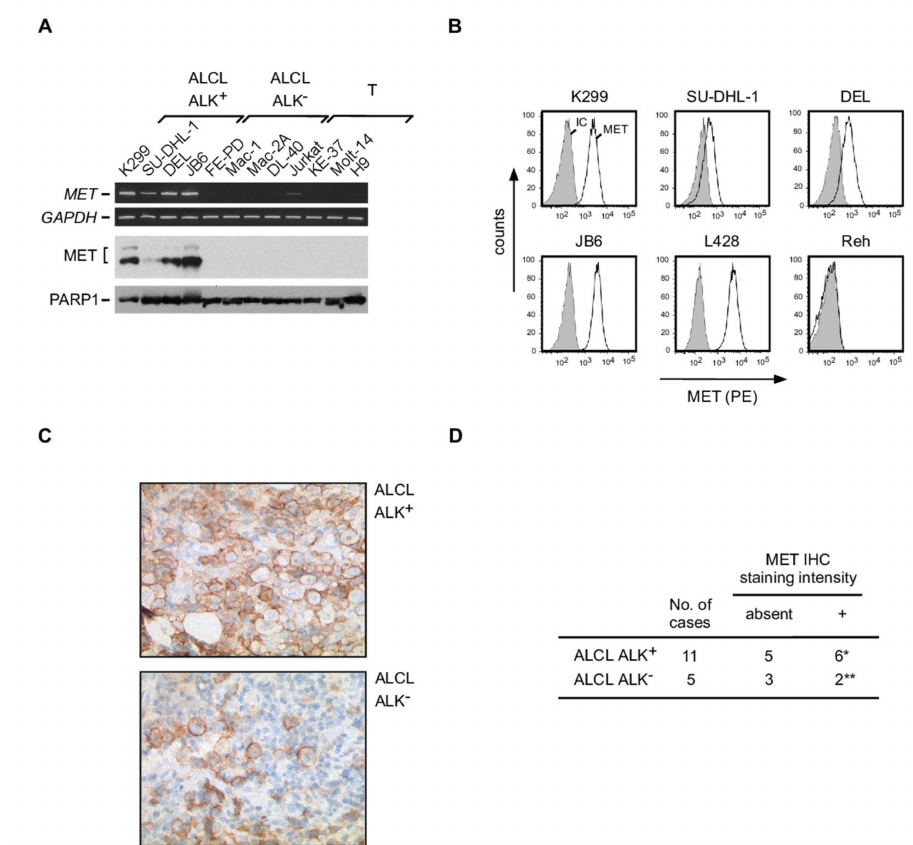
Figure 4. Expression of MET in ALCL. ( A ) Analysis of MET mRNA (upper panel) and protein (lower panel) expression in various ALK + and ALK – ALCL as well as T cell control cell lines, as indicated. The expression levels of GAPDH and of PARP-1 were analyzed as controls, respectively. Note that two MET bands are detectable at the protein level, corresponding to the precursor protein pro-MET (upper band) as well as MET (lower band). ( B ) Cell surface expression analysis of MET in four ALK + ALCL cell lines (K299, SU-DHL-1, DEL, JB6) by extracellular flow cytometry. L428 cells with a known MET expression [48] were included as positive control, Reh cells as negative control. Open histogram, MET staining; filled histogram, isotype control (IC). ( C ) Examples of MET IHC of an ALK + ALCL case (upper panel) and an ALK – ALCL case (lower panel) with moderate tumor cell positivity. Note the cytoplasmic and partially membranous staining of the large ALCL cells. Magnification, 40X. ( D ) Results of MET IHC analyses in ALK + and ALK − ALCL. *, the percentage of positive ALCL cells among the cases was as follows: in 2 cases 60% of the lymphoma cells stained positive (in both cases including membranous staining), in 1 case 10%, in 2 cases 5%, in 1 case single positive cells. **, the percentage of positive ALCL cells among the cases was as follows: in 1 case 40%, in 1 case 10%. Staining intensity is indicated as follows: +,